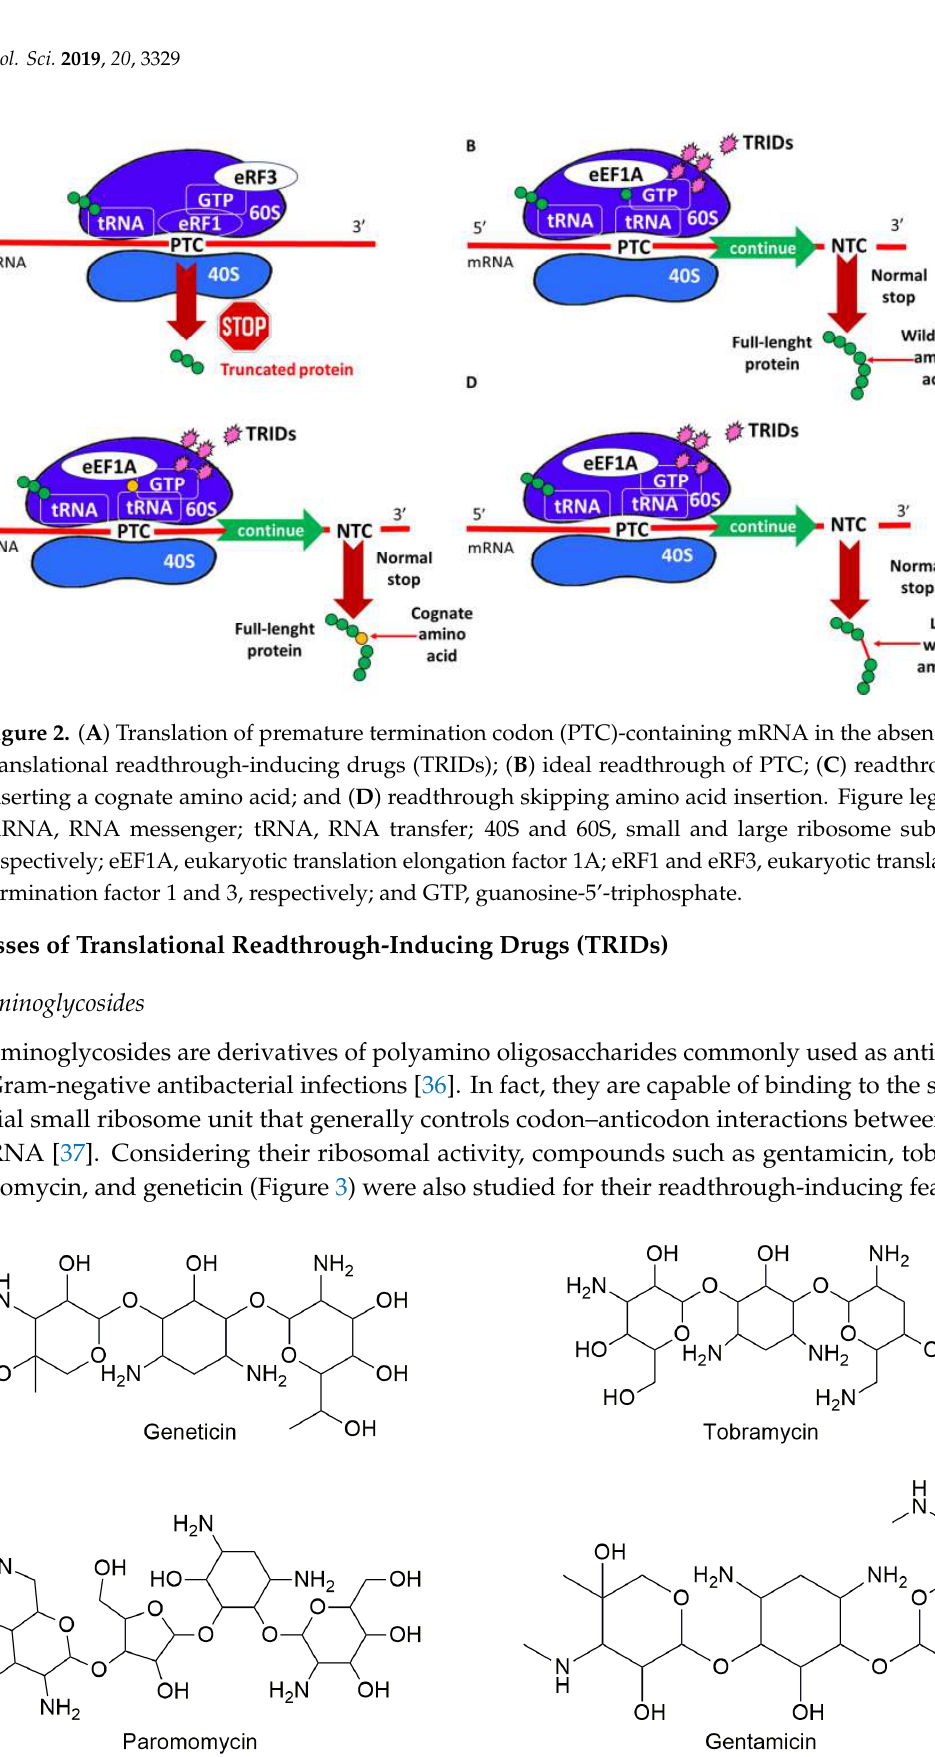
Figure 3. Structures of some aminoglycoside antibiotics studied for readthrough ability.